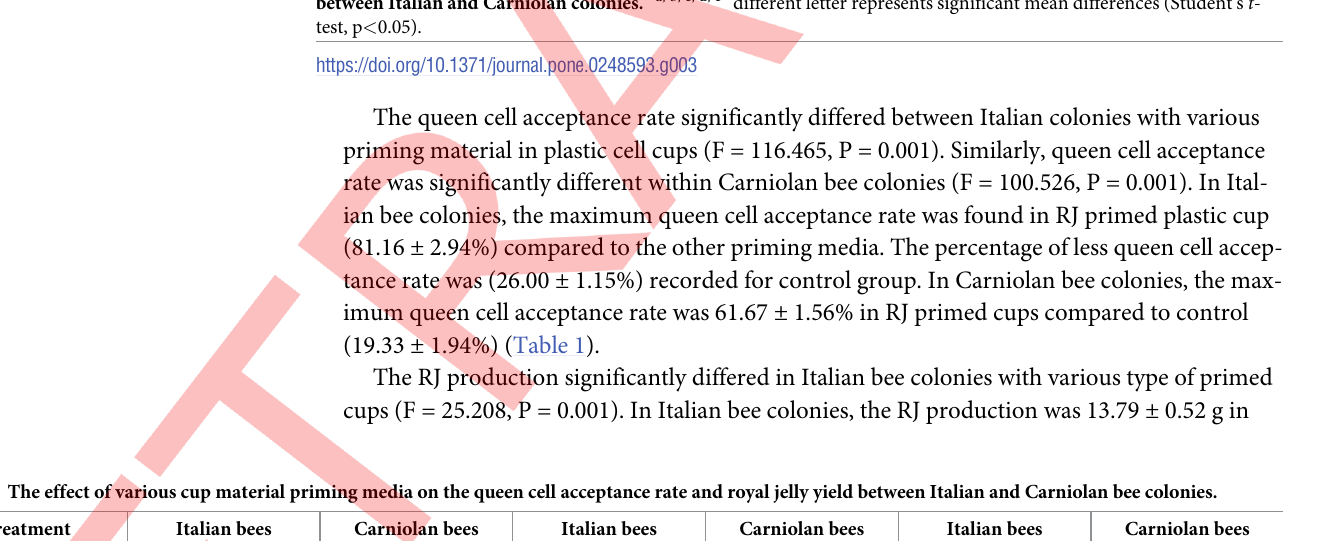
Table 1. The effect of various cup material priming media on the queen cell acceptance rate and royal jelly yield between Italian and Carniolan bee colonies. Treatment Italian bees Carniolan bees Italian bees Carniolan bees Italian bees Carniolan bees Queen cell acceptance rate (%) Weight (g) of royal jelly/ colony Weight (mg) of royal jelly/ cell cup Mean ± S. Error Mean ± S. Error Mean ± S. Error Mean ± S. Error Mean ± S. Error Mean ± S.